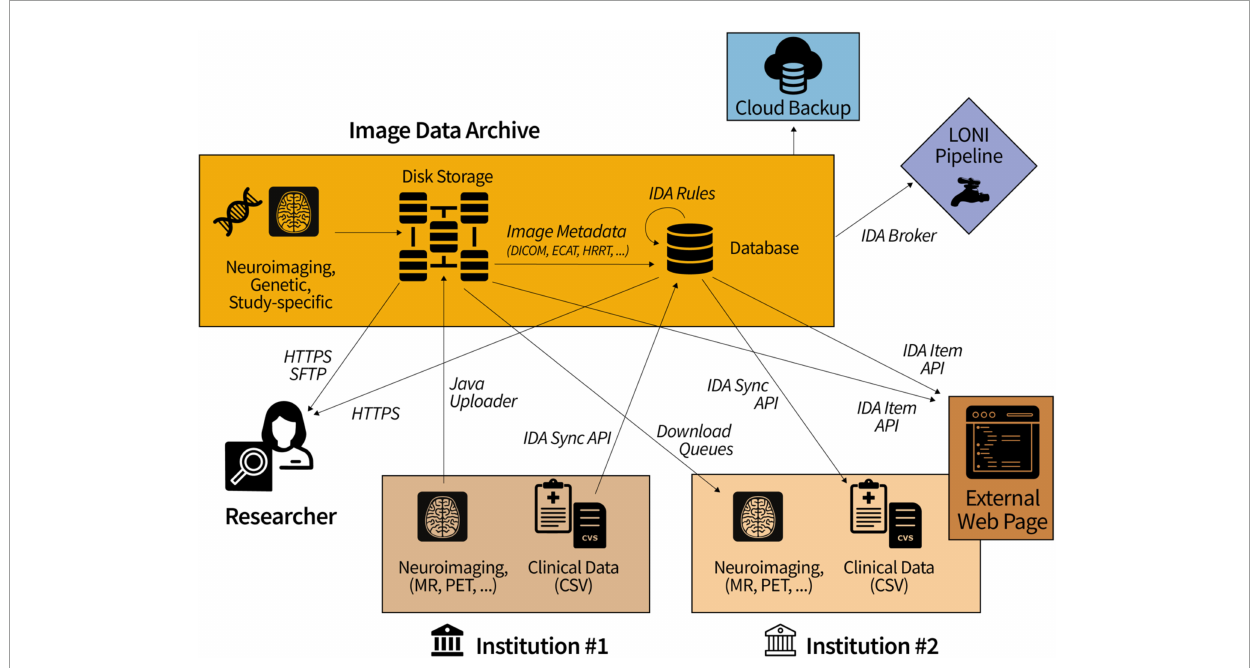
FIGURE3 Collaborating institutions transfer data to and from the IDA while study committees allow access to approved researchers. In the diagram, Institution #1 uploads locally-acquired neuroimaging scans and clinical data. Download queues and the IDA Sync API make this data readily accessible to other institutions (e.g., Institution #2) for processing and